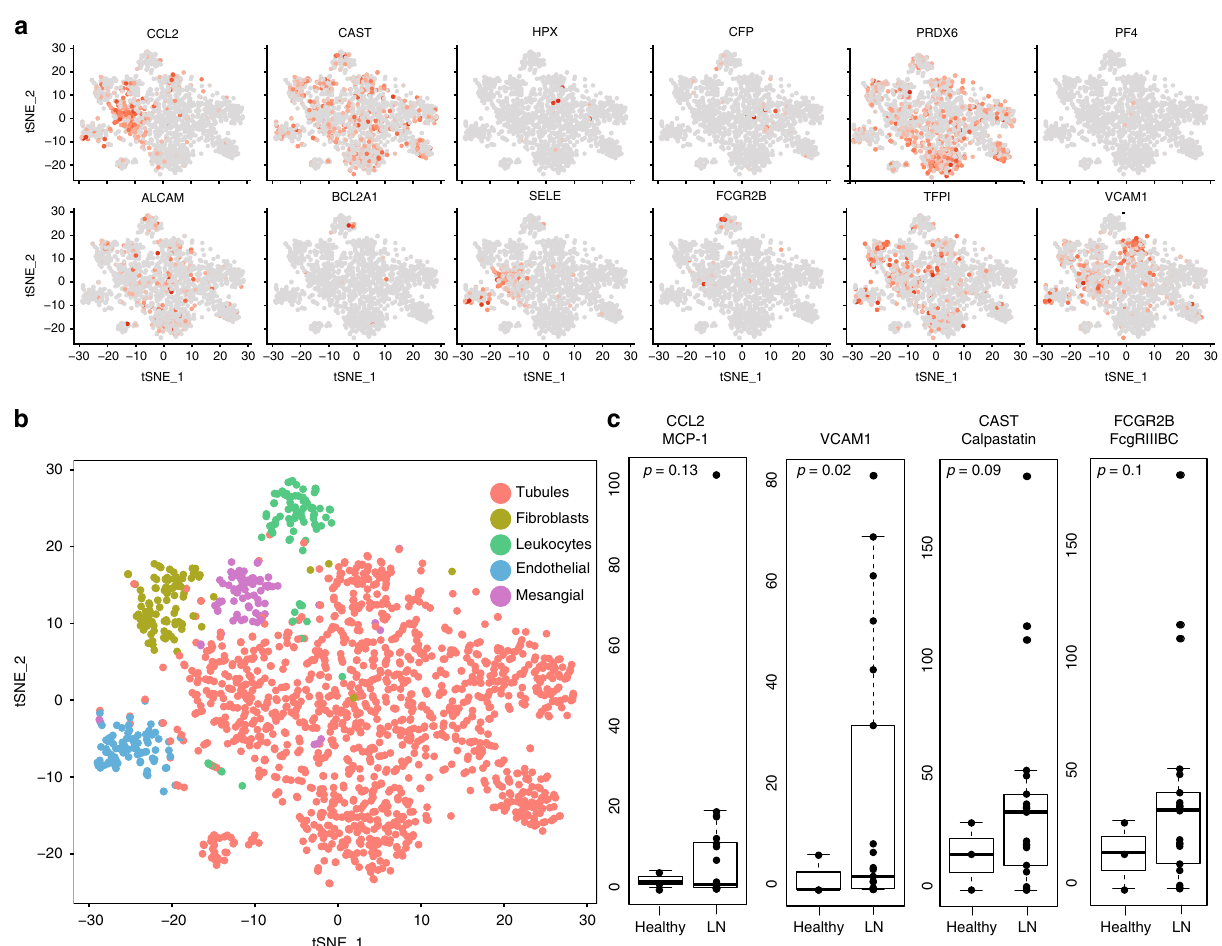
Fig. 5 Renal single-cell RNAseq expression of potential urine biomarkers in LN and healthy controls. a Feature plots of potential urine biomarkers where each dot is a cell and the color intensity (gray = low, to red = high) indicates expression of the indicated gene within each cell, as deduced by RNAseq data analysis of 21 LN renal tissue samples. CCL2 = MCP-1; CAST = calpastatin; HPX = hemopexin; PRDX6 = peroxiredoxin-6; BCL2A1 = BFL-1; SELE = sE- selectin. b tSNE plot of 1624 cells obtained from the renal biopsy of 21 LN patients and 3 healthy controls. Clusters are derived from PCA and graph-based clustering analysis and color-coded based on identi fi ed cell type. c Student ’ s t -test comparison of expression of CCL2 (MCP-1), VCAM-1, CAST (calpastatin), and FCG2RB between LN patients ( N = 21) and healthy controls ( N = 3) within the single-cell RNAseq dataset. The ends of the box represent the upper and lower quartiles, so the box spans the interquartile range. The median is marked by a horizontal line inside the box. The whiskers are the two lines outside the box that indicate 1.5 times the interquartile range from the upper or lower